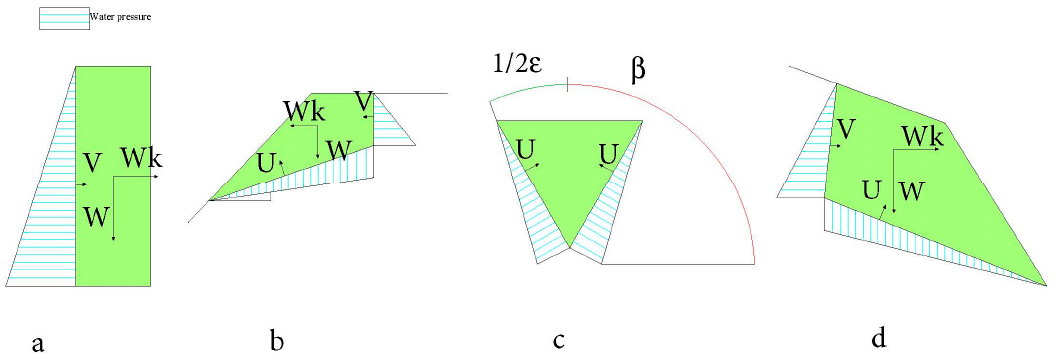
Figure 6. Typical block geometries assumed for slope stability. ( a ) Toppling; ( b ) wedge sliding (longitudinal section); ( c ) wedge sliding (transversal section); ( d ) planar sliding. W—mass weight, U and V—water force, Wk—pseudostatic horizontal force, α —sliding surface dip, β —tilt angle, ε —wedge angle.